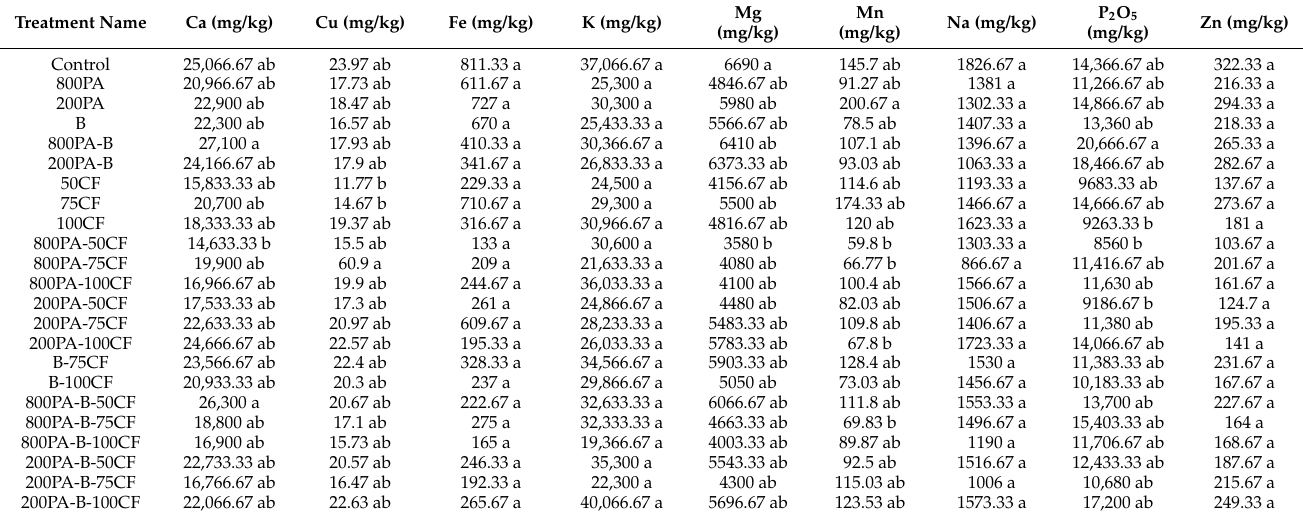
Table 6. Nutrient content in Komatsuna plant leaf samples following application of different treat- ments. 800PA: pyroligneous acid diluted 800-fold; 200PA: pyroligneous acid diluted 200-fold; B: Biochar; 50CF: 50% chemical fertilizer; 75CF: 75% chemical fertilizer; 100CF: 100% chemical fertilizer. Different lowercase letters indicate significant difference at p < 0.05 as indicated by Tukey’s